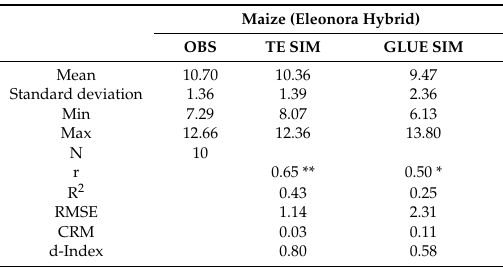
Table 13. Statistical results of observed (OBS) and simulated (SIM) values of grain yield (t ha − 1 ) of maize (Eleonora hybrid) for the evaluation of CSM-CERES-Maize